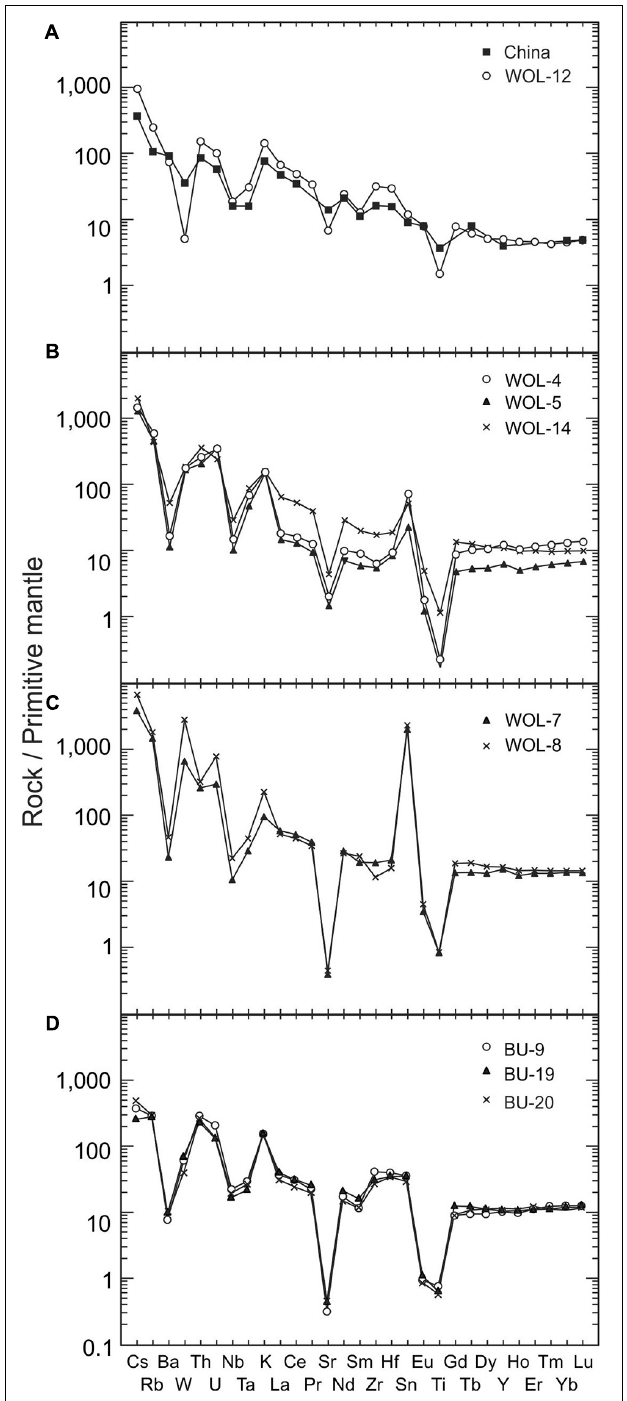
FIGURE 10 | Primitive-mantle normalized incompatible element abundances for the granitic rocks of the Tukham and Bayan-Ulan plutons. (A) Phase 1 TP granite (WOL-12) and an estimate of total crust of Eastern China (Gao et al., 1998); (B) phase 2 TP granites (WOL-14 typical biotite granite; WOL-4 and WOL-5 altered leucogranites); (C) TP strongly altered granites; and (D) granites of the Bayan-Ulan pluton. Elements are arranged in the order of decreasing incompatibility from left to right. Normalizing values are after Sun and McDonough (1989).